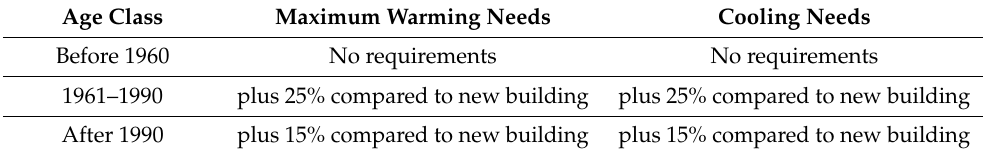
Table 3. Maximum energy needs for major renovated residential buildings according to REH.